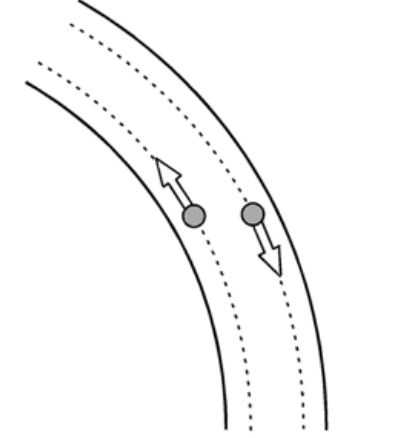
outward.FIG. 1. The conceptual illustration of the shearing force. If all stored particles in a crystalline ground state have the same longitudinal velocity, the revolution frequency of a radially outer particle becomes longer than that of an inner particle. Consequently, the two particles are more and more distanced longitudinally every turn, which eventually leads to the melting of the crystalline state. The strength of the shearing force is closely related to the momentum dispersion, as shown in Sec.